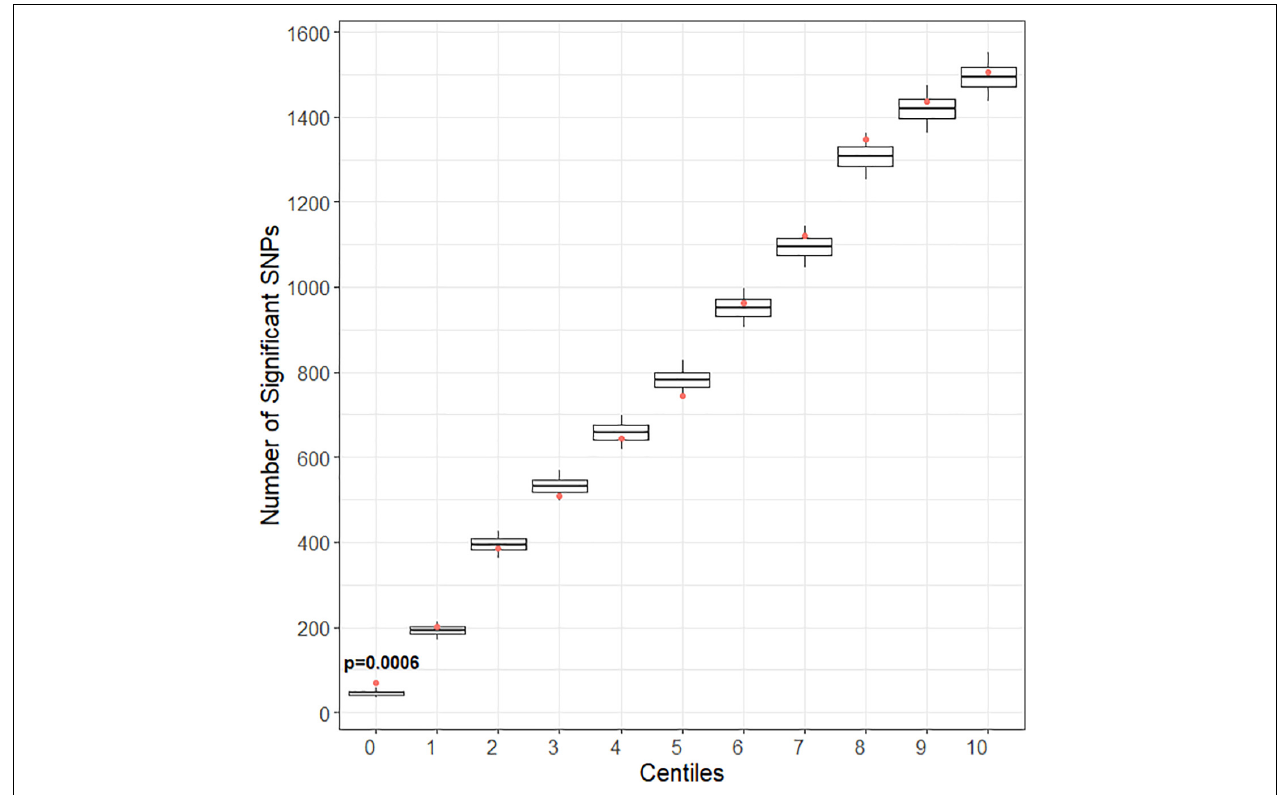
FIGURE 2 | Gene enrichment analyses for pain score at 6–12 months as outcome. Centiles represent the portion of case genes used in the genetic assocaition analysis. 0% includes the training set of gene variants, 10th percentile includes the training list plus the top 10% highest ranked genes, and so forth, vertical axis represents the number of variants. Box plots represent the cumulative number of SNPs with signficant association with pain score at 6–12 months after surgery [chronic post-surgical pain (CPSP) continuous outcome] ( p < 0.05) in 10,000 runs of control gene variants. The dot indicates the cumulative number of nominal associations ( p < 0.05) identified for case genes. Enrichment is indicated when a greater number of genetic associations are present in case versus control genes, that is, when the number of associations in case genes (red dot) (80 variants/1010 variants) exceeded the upper 95th percentile threshold in the 10,000 runs of the control set. For CPSP continuous outcome, we see enrichment in the training set of variants ( p < 0.001). The training set incudes 80 variants showing association with CPSP ( p < 0.05).